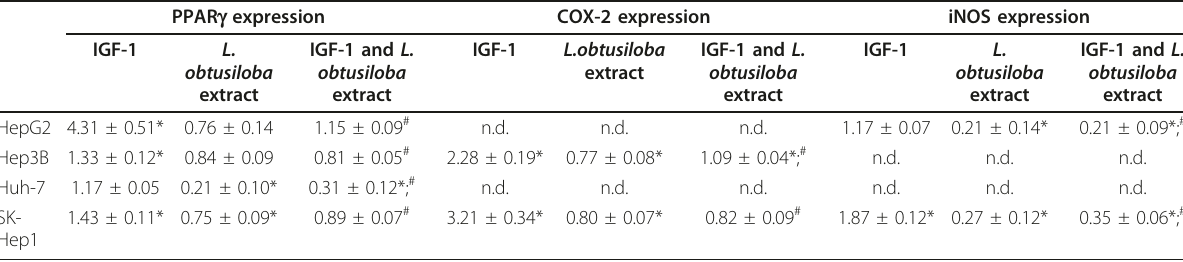
Table 2 Expression of PPAR g , COX-2 and iNOS in human HCC cell